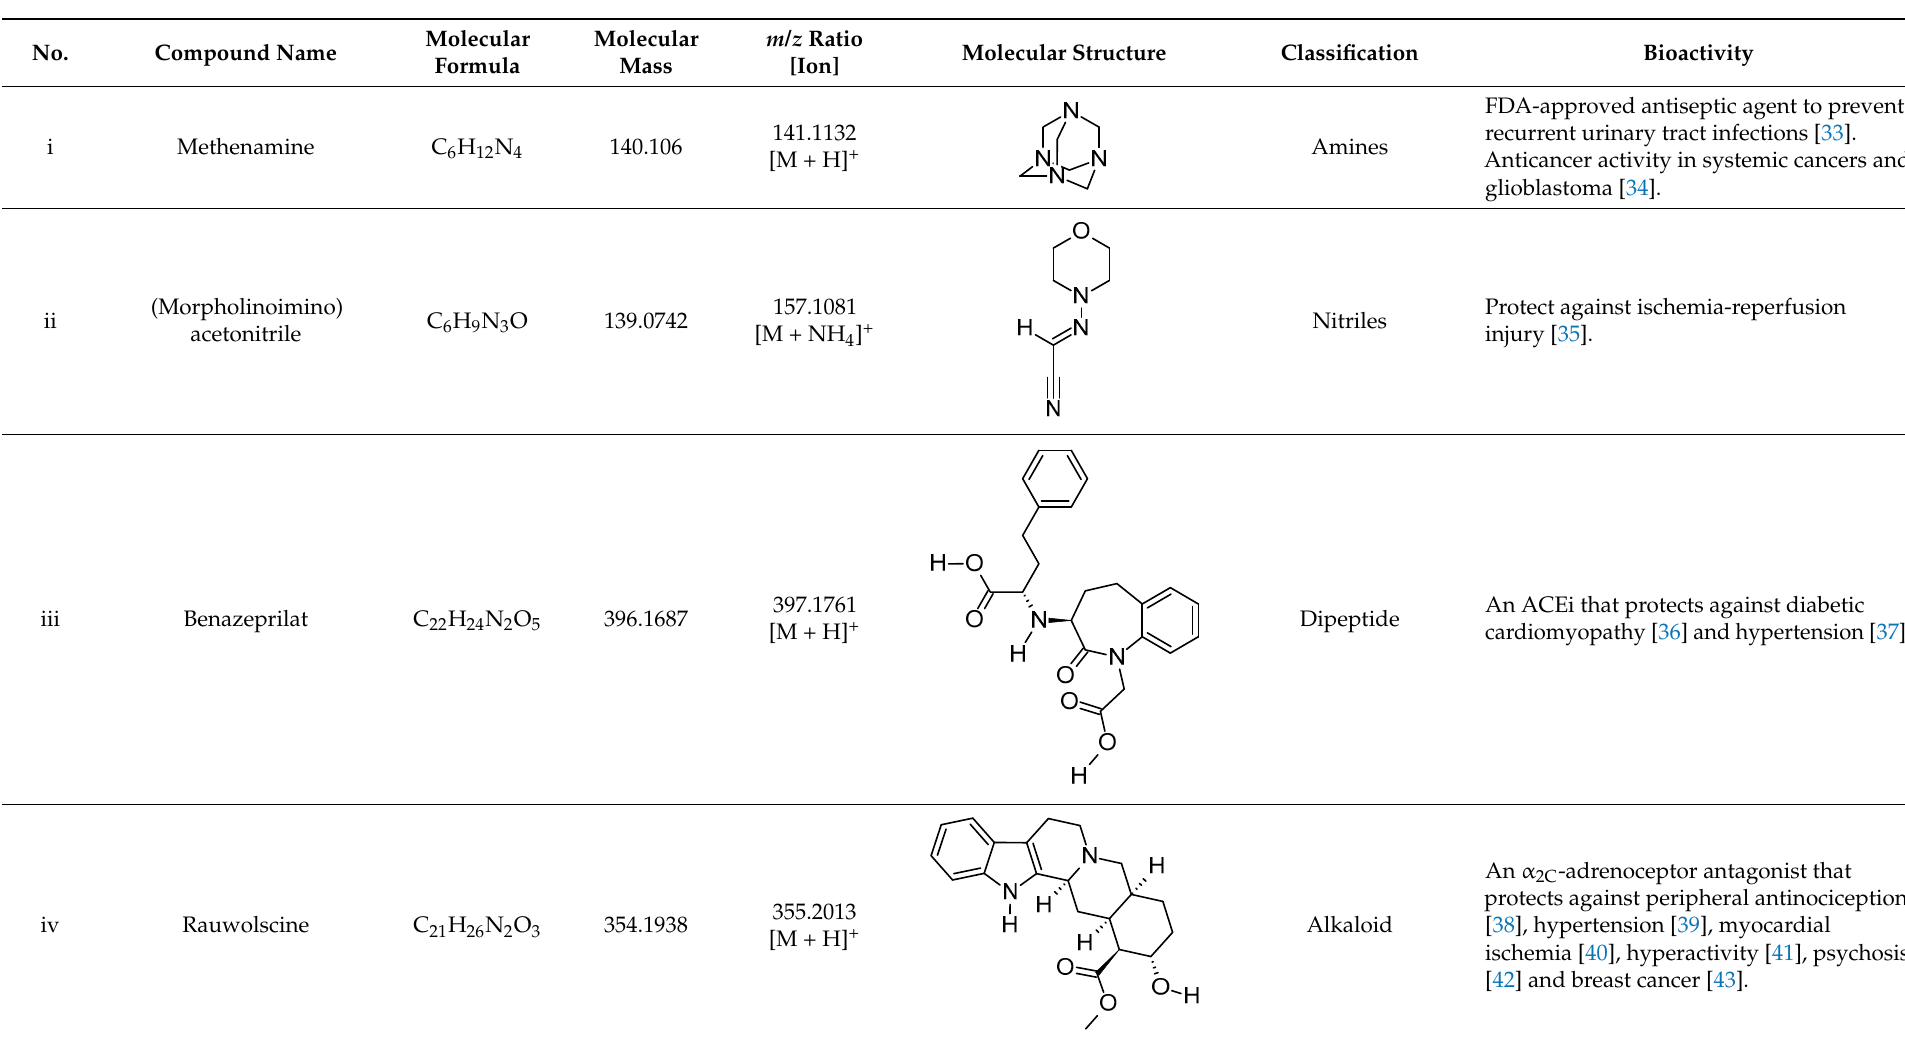
Table 3. Tentatively identified compounds in S. platensis ethanol extract.